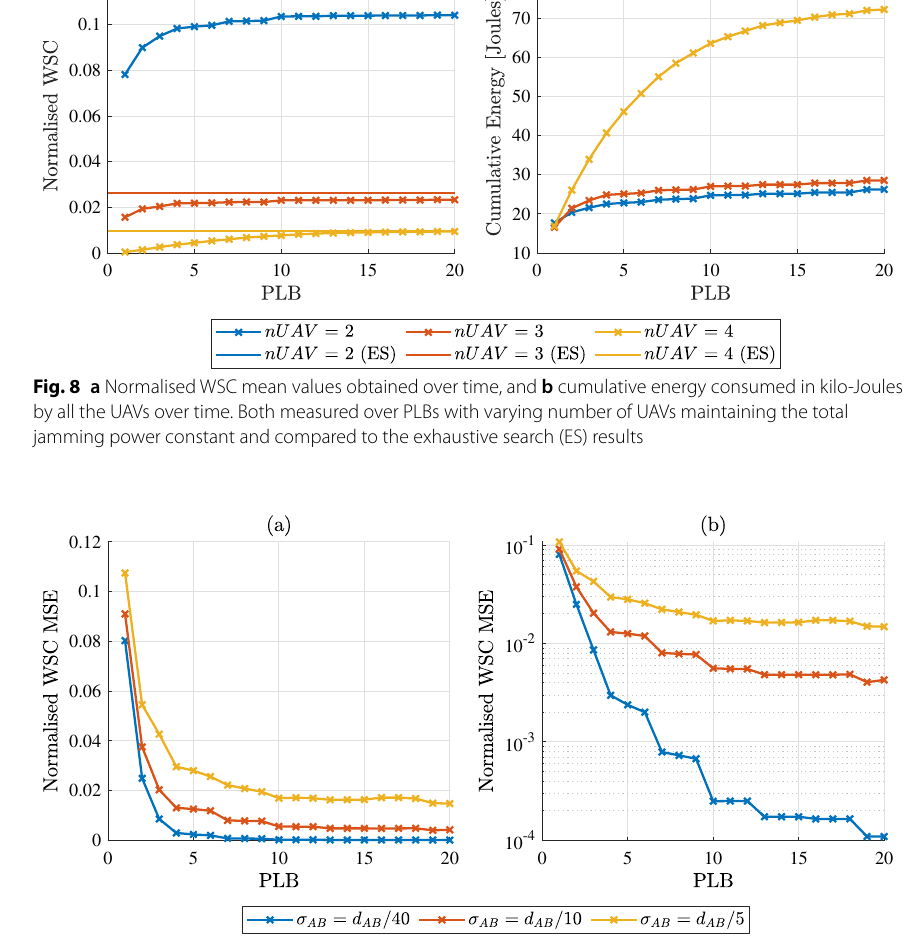
Fig. 9 Normalised MSE of WSC obtained with the algorithm, compared to exhaustive search results over time for varying values of in a linear scale and b semilogarithmic scale. Both measured over PLBs with varying uncertainty of the distance between A and B σ